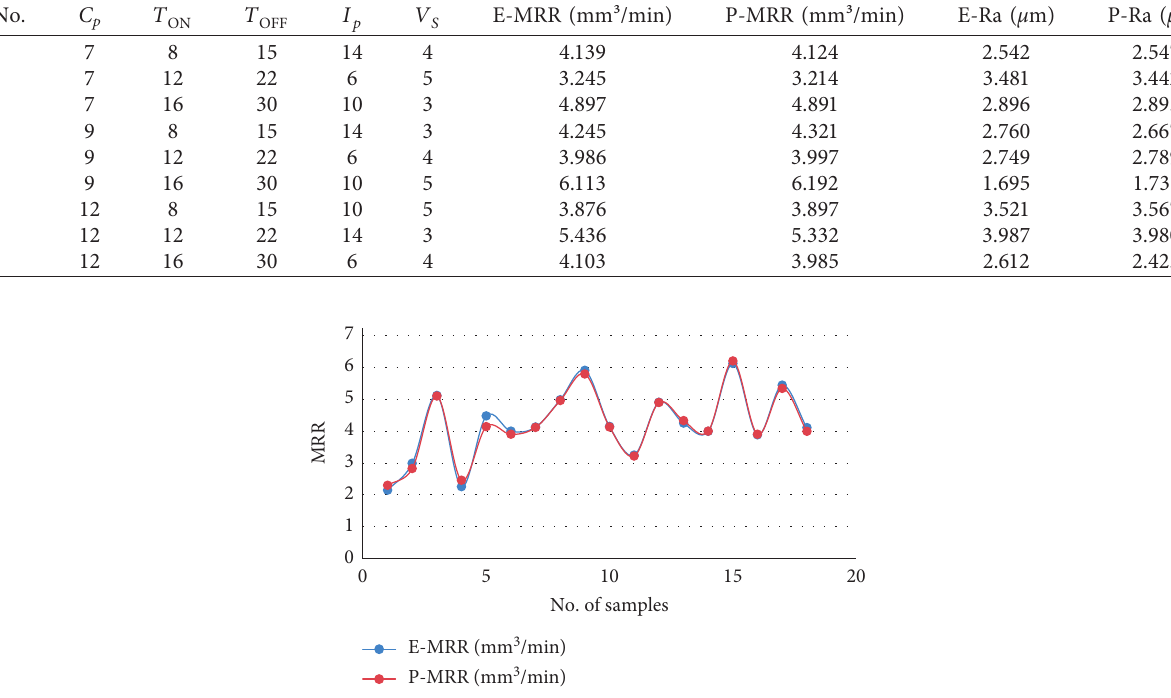
Figure 9: Performance comparison of obtained values of E-MRR and P-MRR for number of samples.